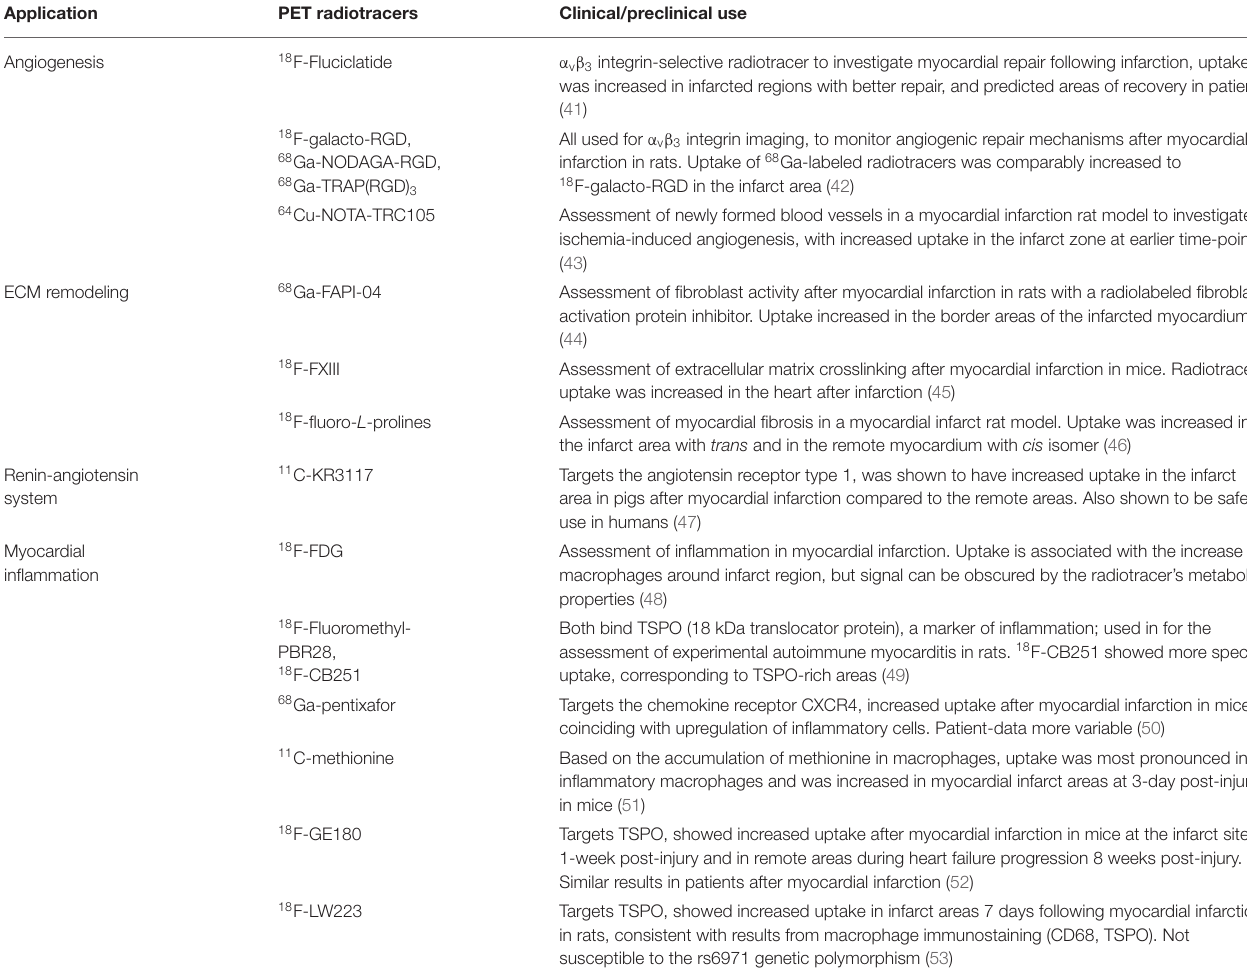
TABLE 2 | Current and emerging PET radiotracers for cardiac imaging of angiogenesis, extracellular matrix remodeling, the renin-angiotensin system and myocardial